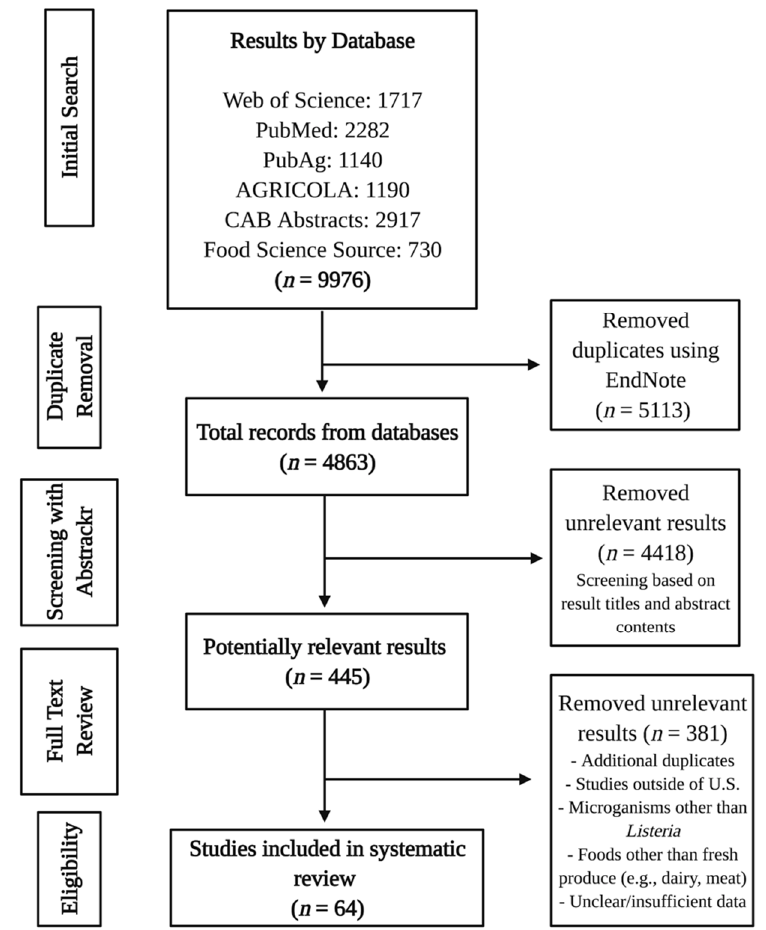
Figure 1. Flow diagram illustrating the systematic literature review process.